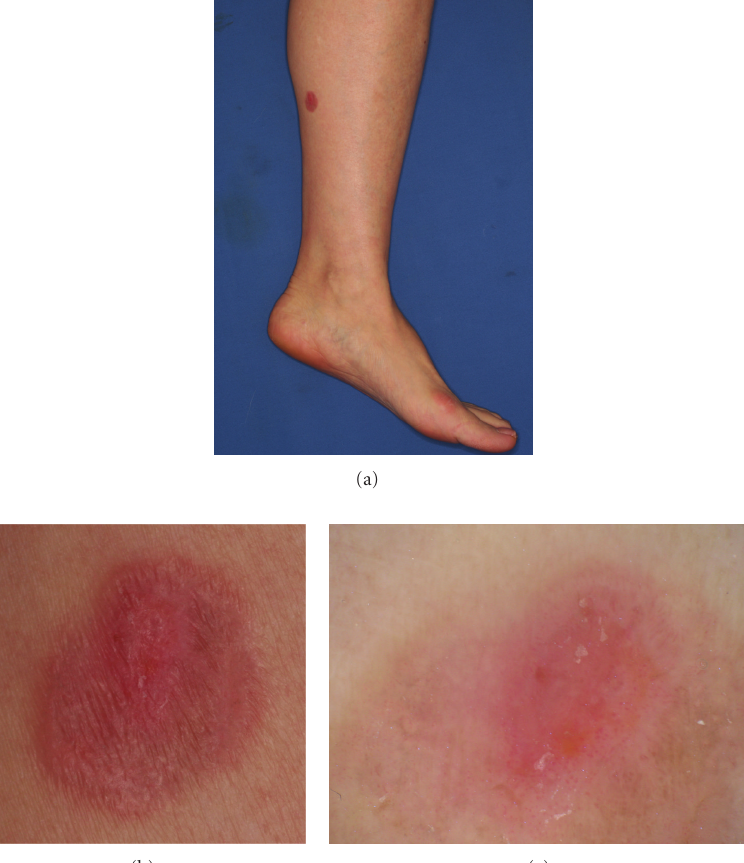
Figure 1: (a) A solitary slightly palpable scaly erythema on the left leg. (b) The lesion is sharply marginated with a scaly surface. (c) The dermoscopic examination demonstrated dotted and glomerular vessels with a homogenous pinkish background. A broad and indistinct whitish negative network is seen at the periphery.